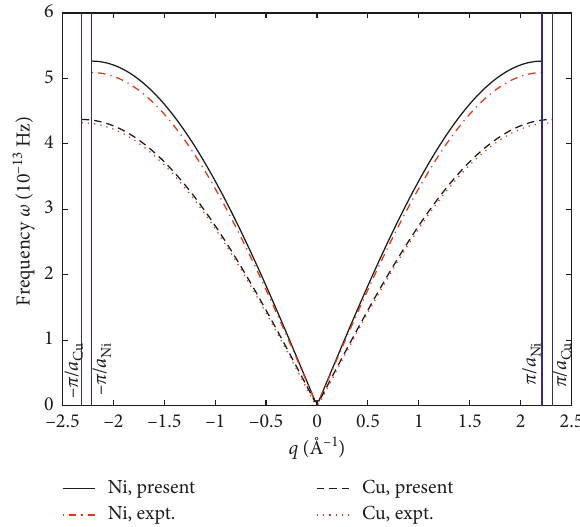
Figure 2: Dispersion relations ω the present theory compared to the experimental values (Expt.) [23].